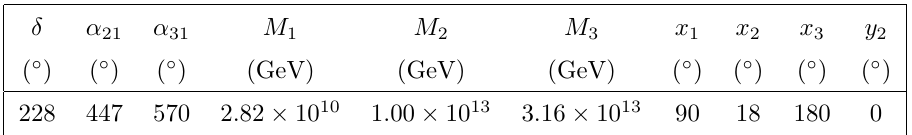
10 10 GeV, with normal (cid:2)